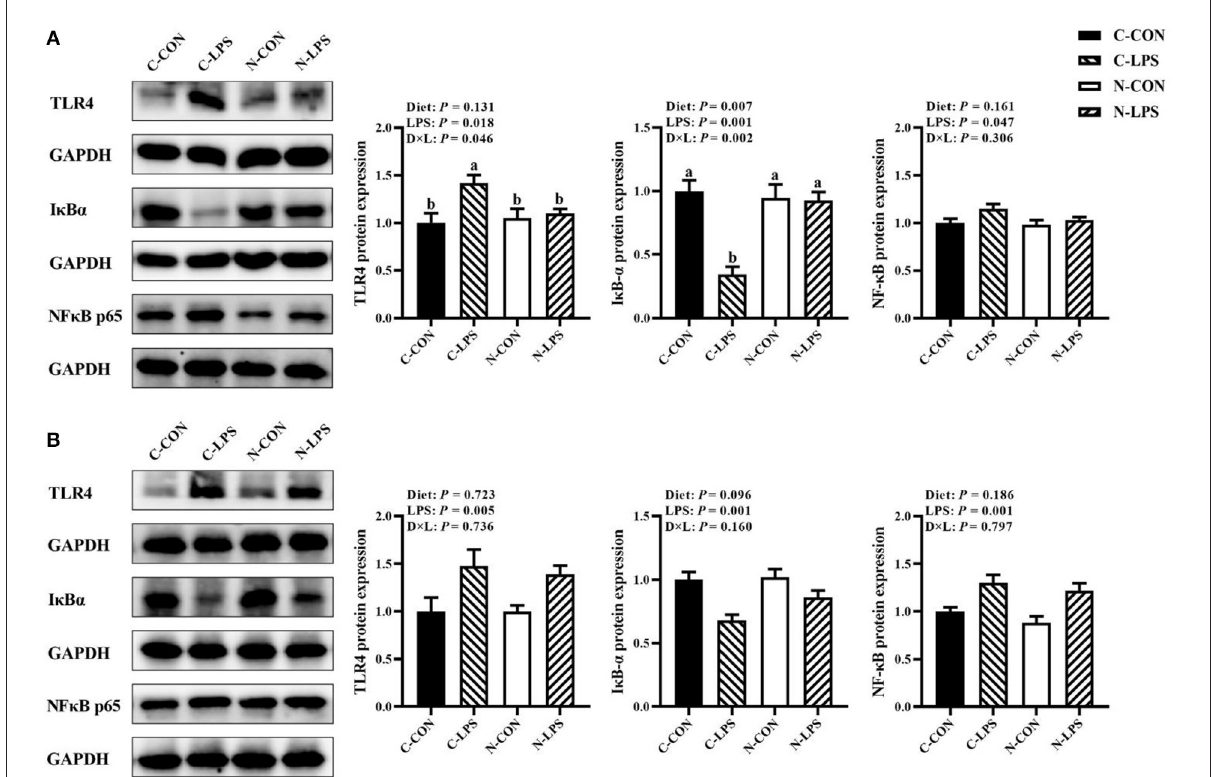
FIGURE4 Effects of maternal nucleotide supplementation on inflammation-related protein expression in jejunum and ileum in lipopolysaccharide- challenged newborn piglets. (A) Inflammation-related protein expression in jejunum. (B) Inflammation-related protein expression in ileum. Results were expressed as means with their standard errors, n = 6; a,b Means of the same parameter with different superscripts are significantly different ( P < 0.05). TLR4, toll-like receptor 4; NF κ B p65, nuclear factor kappa B p65 subunit; I κ B α , nuclear factor kappa B inhibitor alpha; GAPDH, glyceraldehyde-3-phosphate dehydrogenase. C-CON, piglets were from the sows fed with basal diets and were challenged by sterile saline; C-LPS, piglets were from the sows fed with basal diets and were challenged by LPS; N-CON, piglets were from the sows fed with basal diets containing nucleotides and were challenged by sterile saline; N-LPS, piglets were from the sows fed with basal diets containing nucleotides and were challenged by